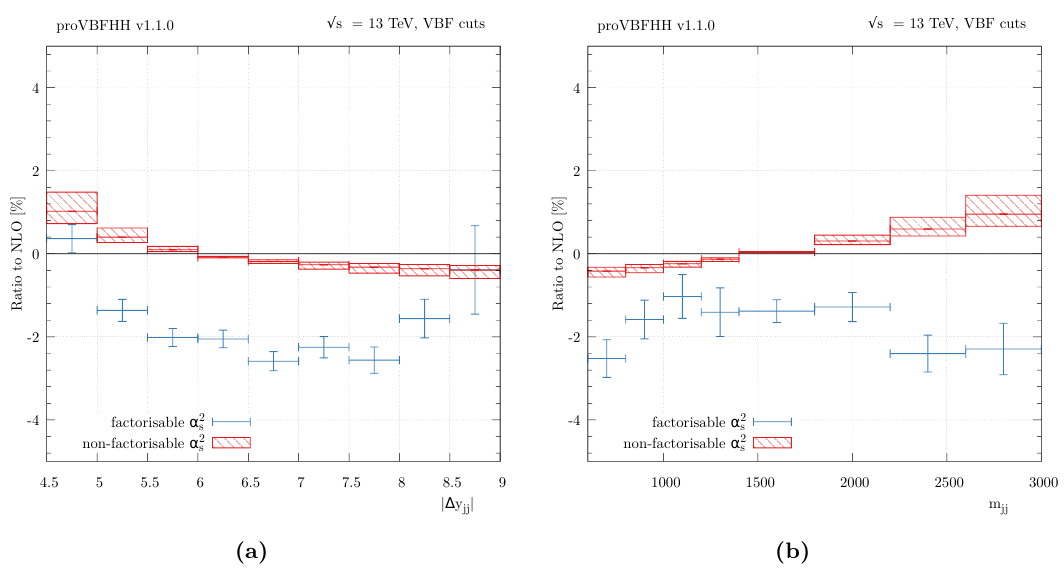
Figure 4. Replaces figure 15.